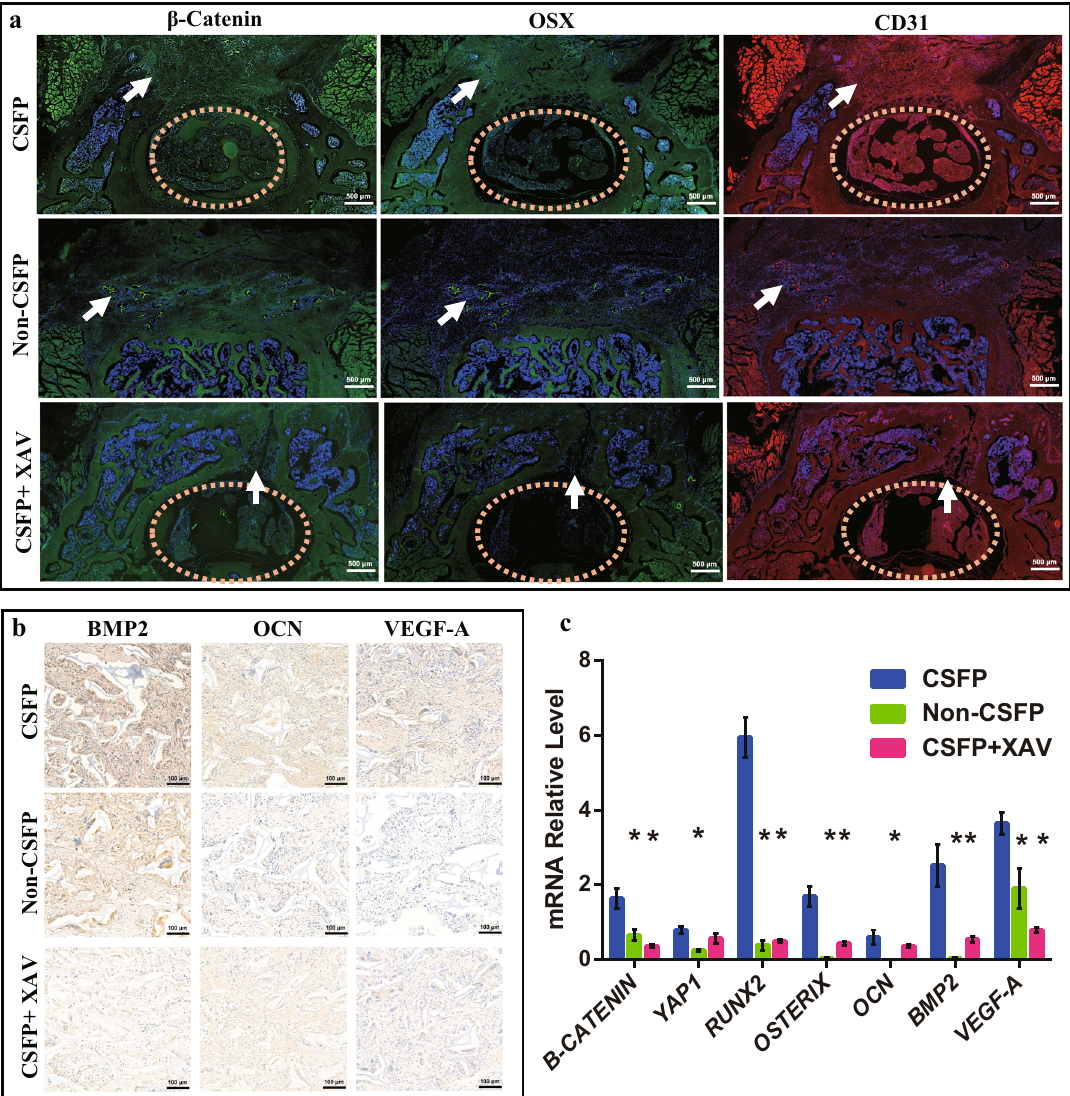
Fig. 5 CSFP promoted the osteogenic and angiogenic abilities of tissue-engineered laminae through the regulation of β -Catenin. a β -Catenin, Osterix, and CD31 IF staining of tissue-engineered laminae (TEL) at the 14th week, the orange dash circle shows the vertebral canal, and the white arrow shows the TEL. b BMP2, OCN, and VEGF-A IHC staining of TEL at the 6th week. c QRT-PCR analysis at the 6th week. Data are presented as mean ± SEM, and * P <